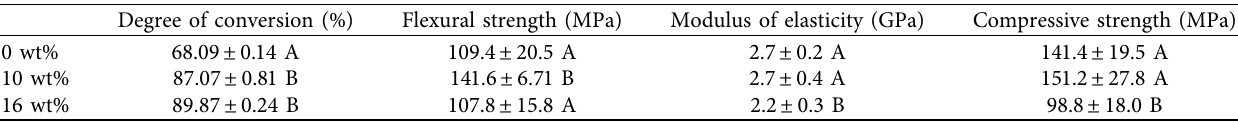
Table 1: Mean ± standard deviation and results of Tukey’s test of degree of conversion, flexural strength, modulus of elasticity, and compressive strength of adhesives.